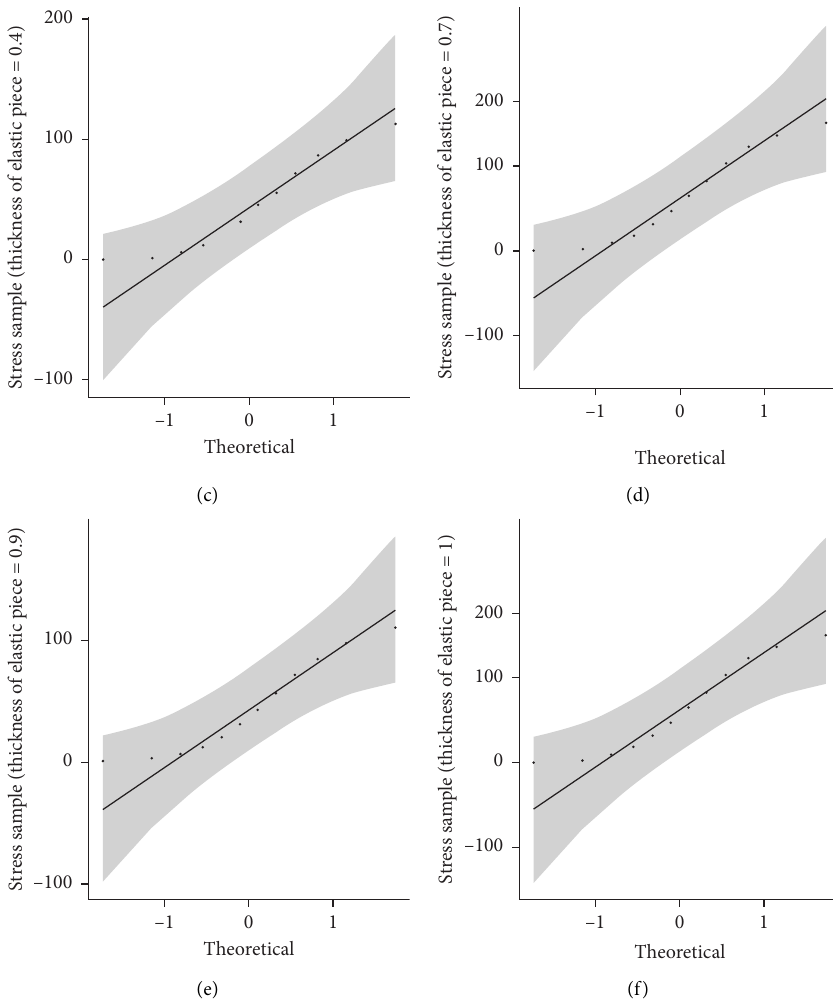
Figure 5: QQ plots testing the normality of the stress’s distribution: (a) thickness � 0, (b) thickness � 0.1 (c) thickness � 0.4, (d) thickness � 0.7, (e) thickness � 0.9, and (f) thickness � 1.